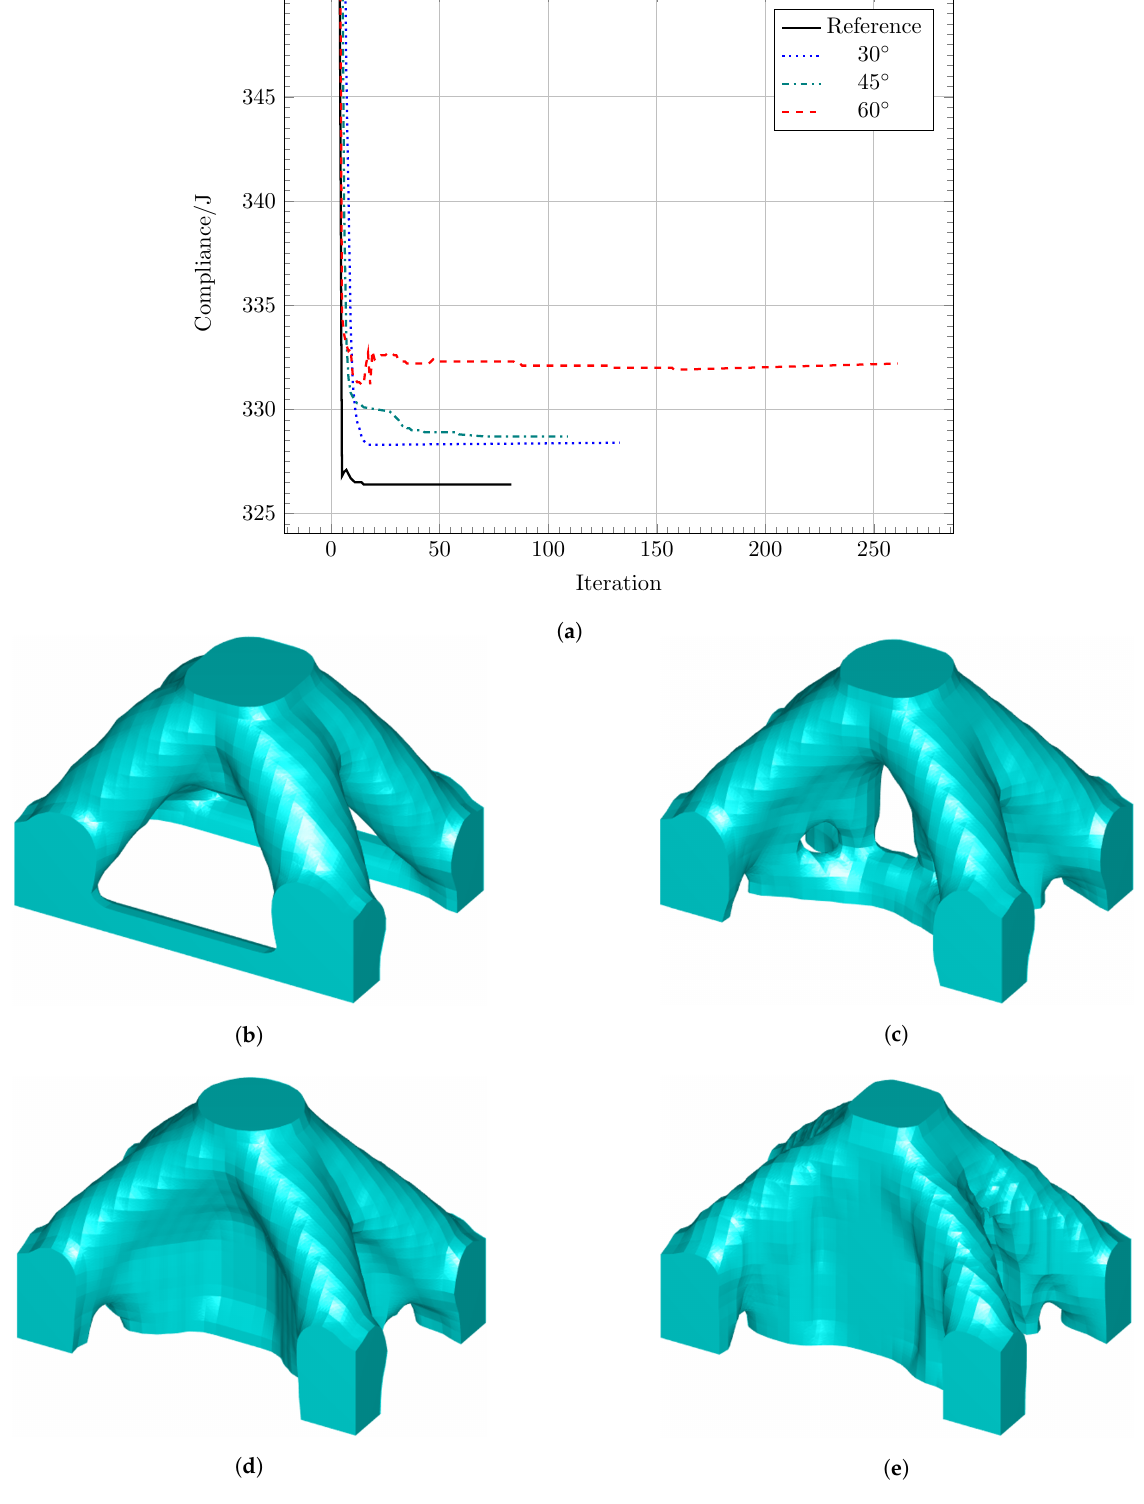
Figure 8. Convergence processes and optimized topologies with different critical overhang angles: ( a ) convergence processes, ( b ) reference, ( c ) 30 ◦ , ( d ) 45 ◦ , ( e ) 60 ◦